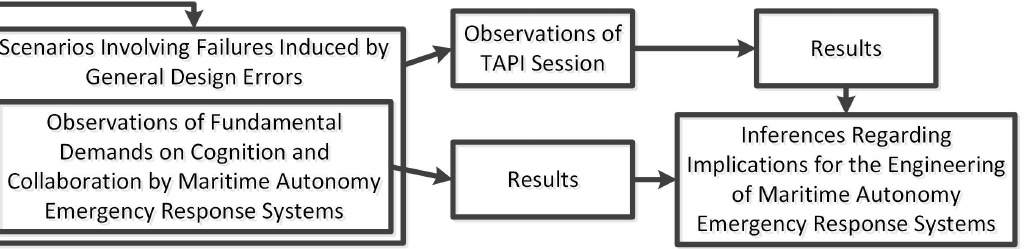
Figure 2. The Data Collection and Analysis